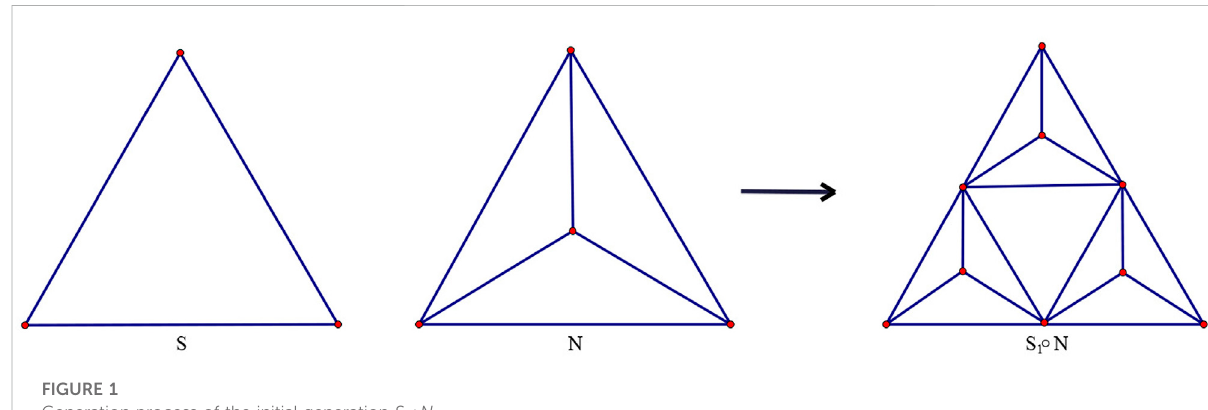
FIGURE 1 Generation process of the initial generation S 1 ◦ N